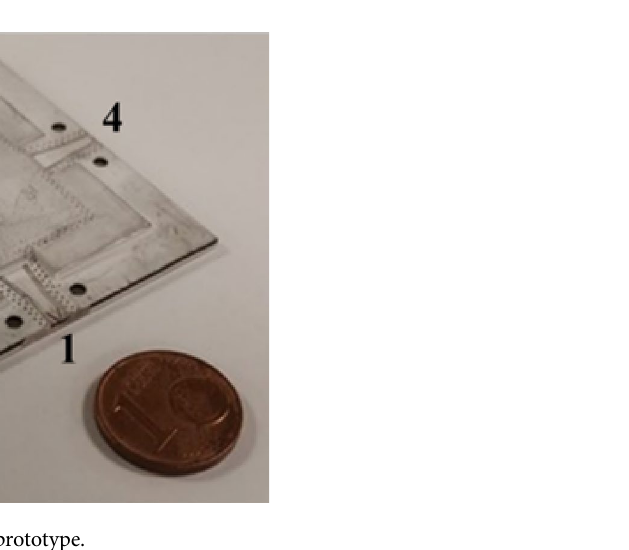
Figure 9. Layout of 4-ports PTD-Symmetric ELC by using grounded-coplanar waveguide to a substrate- integrated waveguide transition.